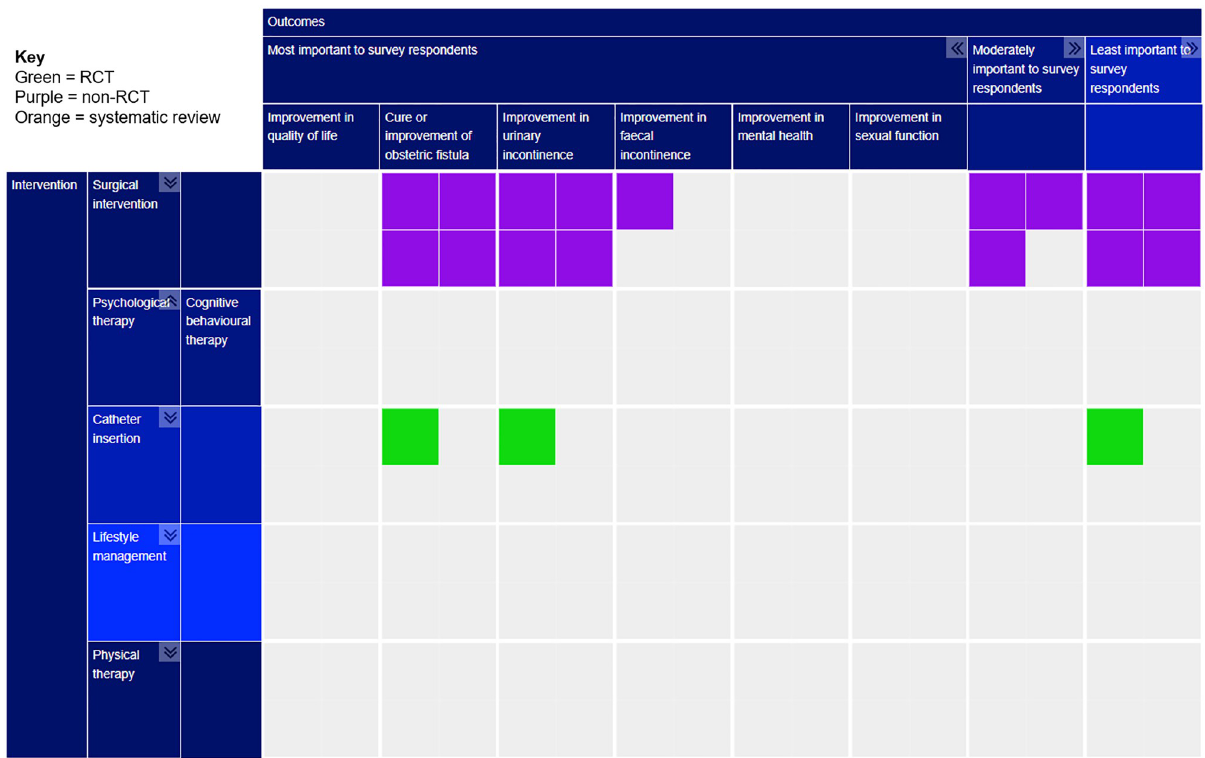
Fig 5. Sensitivity analysis by proportion of participants with obstetric fistula and by whether studies reported interventions separately. Key: Type of study: Green = RCT; Purple = Non-RCT; Orange = Systematic Review.